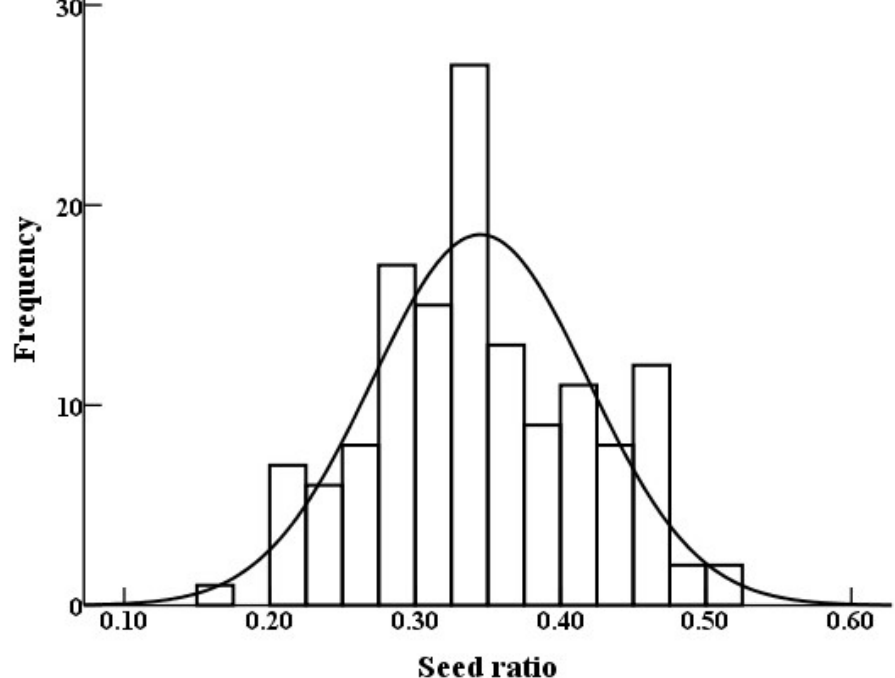
Figure 1. Normal distribution of seed ratio in C. vietnamensis population.